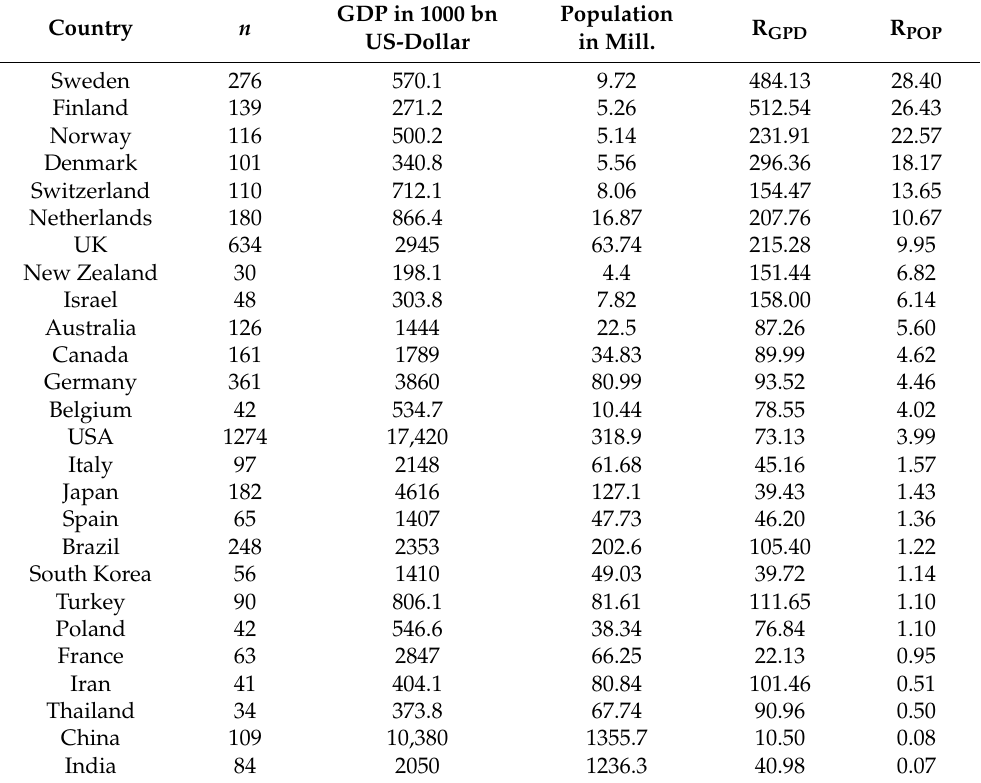
Table 2. Socio-economic analyses (threshold > 30 articles). n = number of articles; GDP = gross domestic product [16]; R GDP = ratio of number of articles and GDP in USD 1000 bn; R POP = ratio of number of articles and population in mill. [16], sorted by R POP